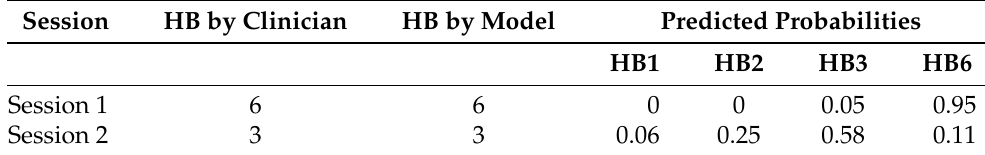
( d ) Probabilities of HB grades predicted by OLR model for the misclassified patient. The classification by a clinician for Session 1 was HB3 and for Session 2 HB1. Figure 10. Comparison between typical patient and misclassified patient classified by OLR model. Data shown in Table 13. Table 13. Classification by OLR model for the typical